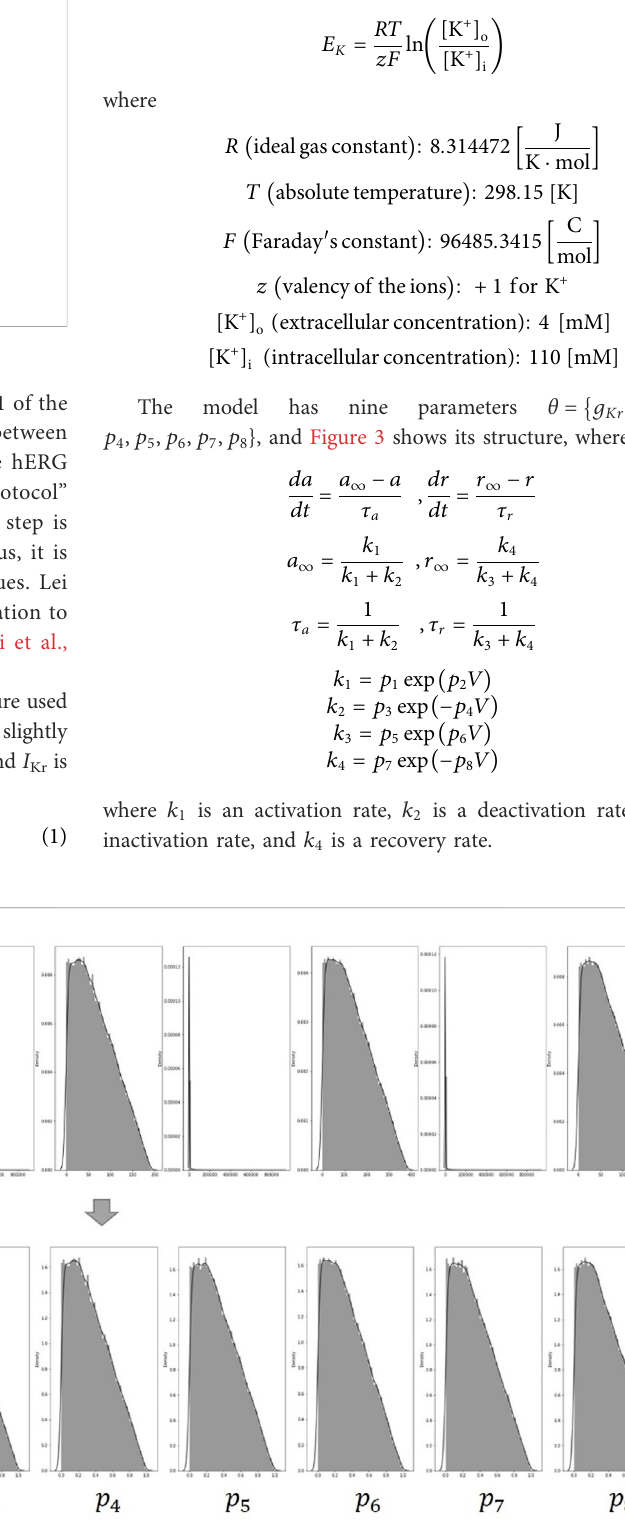
FIGURE 4 (A) DistributionofthenineparametersgeneratedbythetwoconditionsofEqs3,4.Thedistributionsof p 1 ; p 3 ; p 5 ; p 7 areveryclusteredinaspeci fi crange. (B) Data distributions after applying log scale to p 1 , p 3 , p 5 and p 7